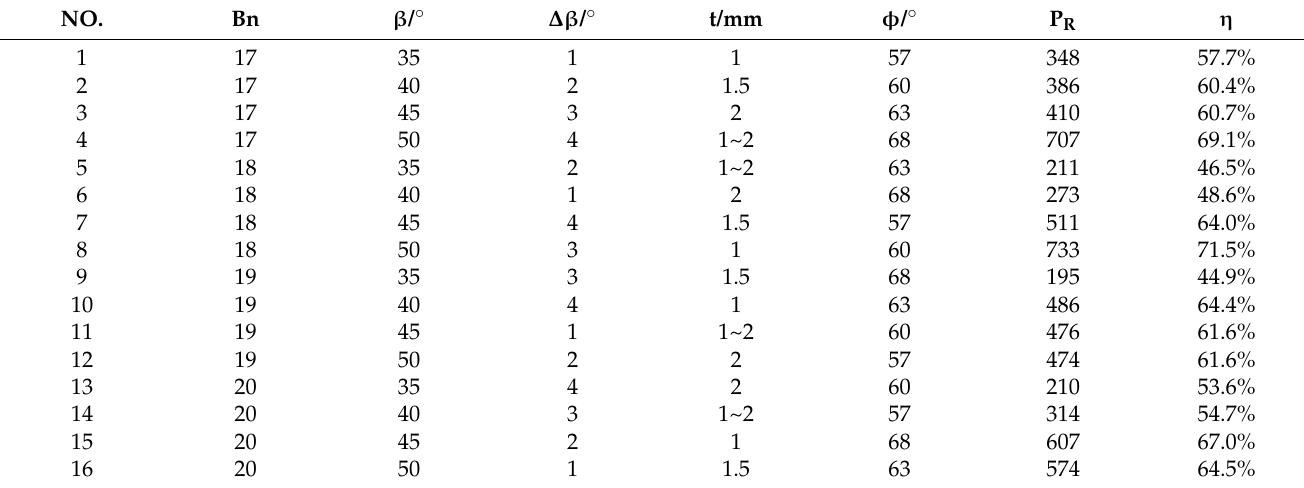
Table 6. Static pressure rise and fan efficiency.